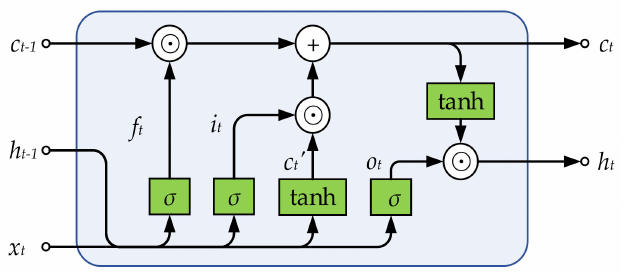
Figure 2. Structure of an LSTM memory